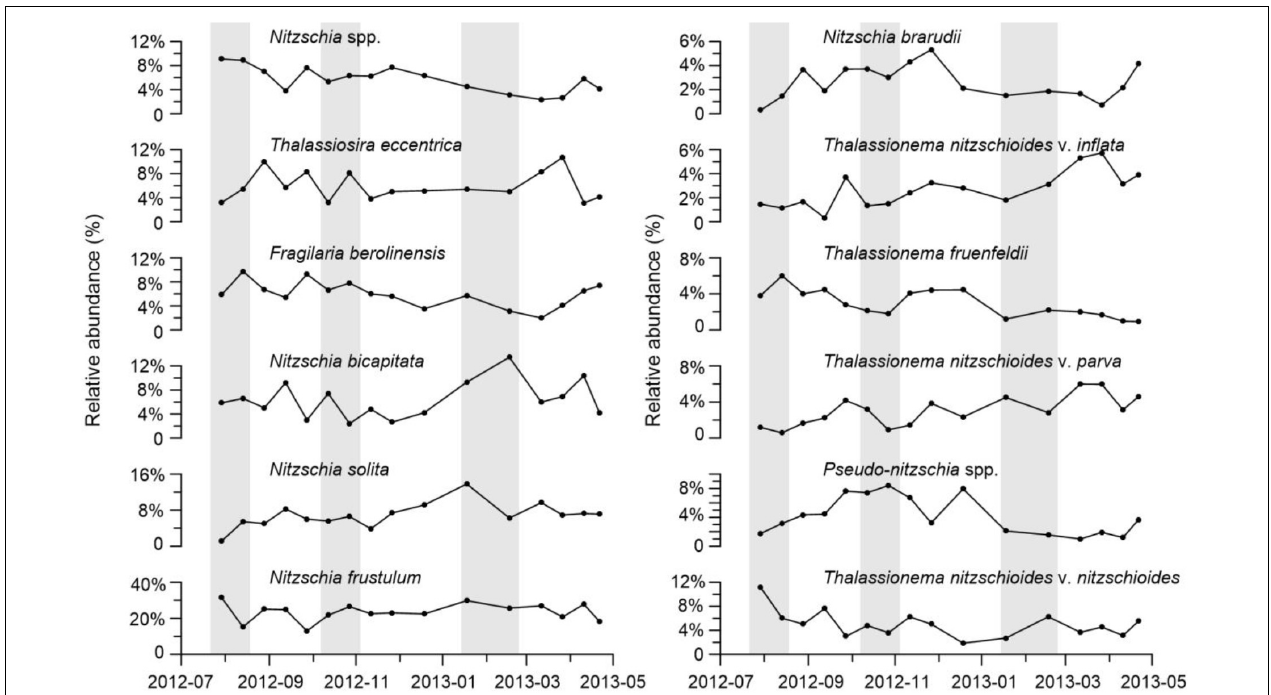
FIGURE 3 | Time-series variation in the relative abundances of the main diatom species (gray bars indicate the three TPF